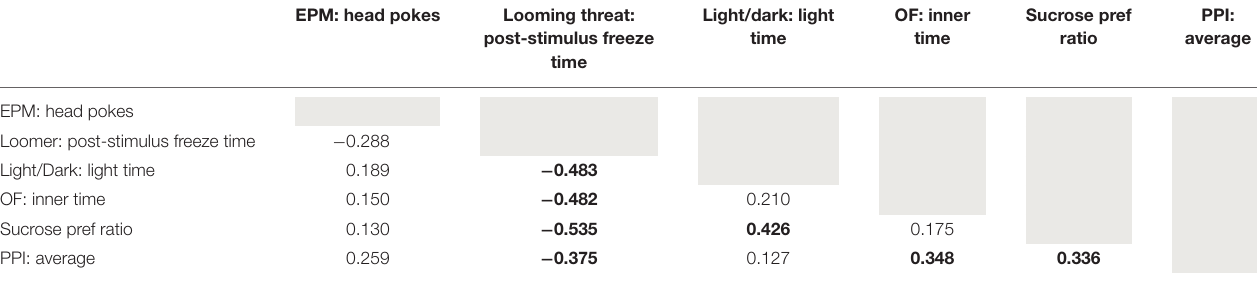
TABLE 1 | Spearman’s correlation coefficients for characterizing behaviors consistent with “trait anxiety.”